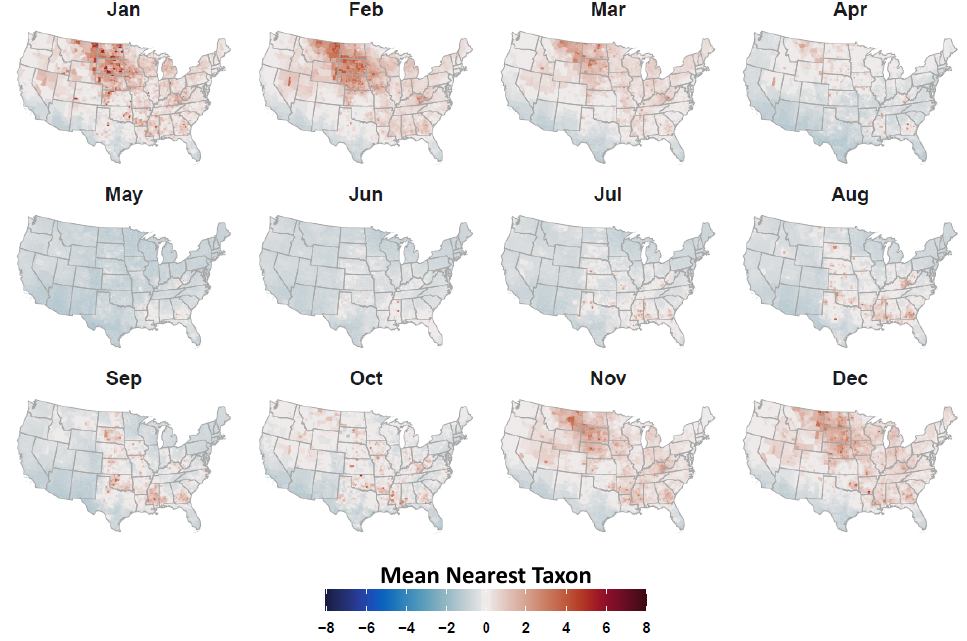
Figure A8. Dynamic avian mean nearest taxon distance. Mean nearest taxon covariate under assumption of a dynamic species pool (monthly varying). Covariate reflects average genetic distance between nearest neighbors (sister species) within a community. Mapped values have been centered to highlight locations subject to relative phylogenetic clustering (higher than expected relatedness, blue colors) and dispersion (lower than expected relatedness, red colors).